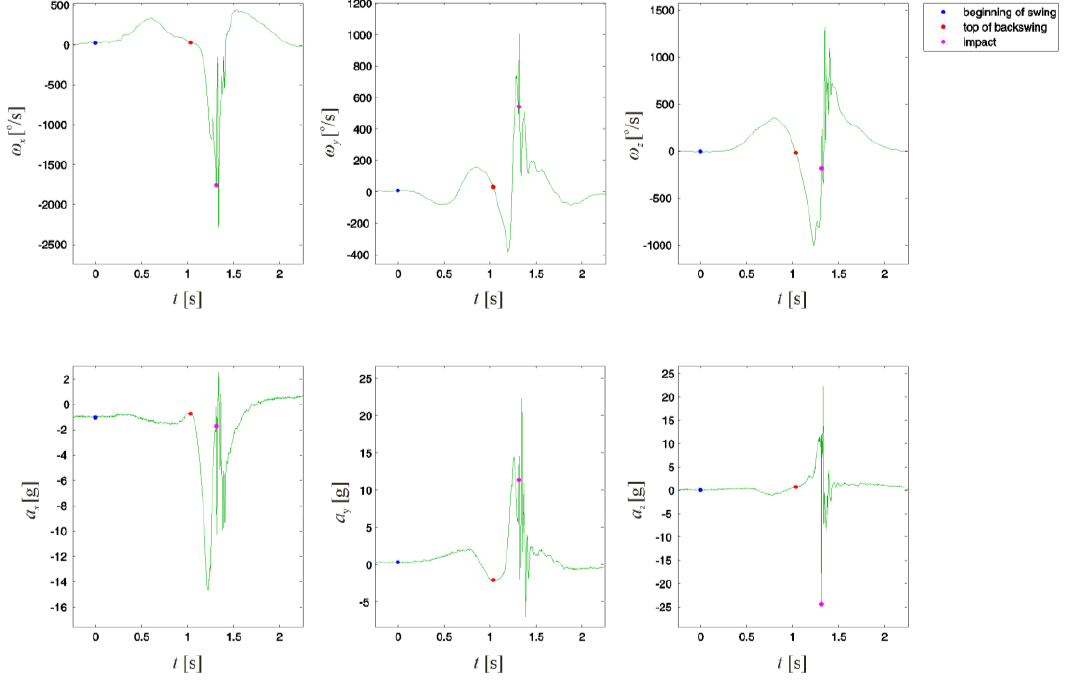
, ω , and ω and accelerations a , a , x y z x y